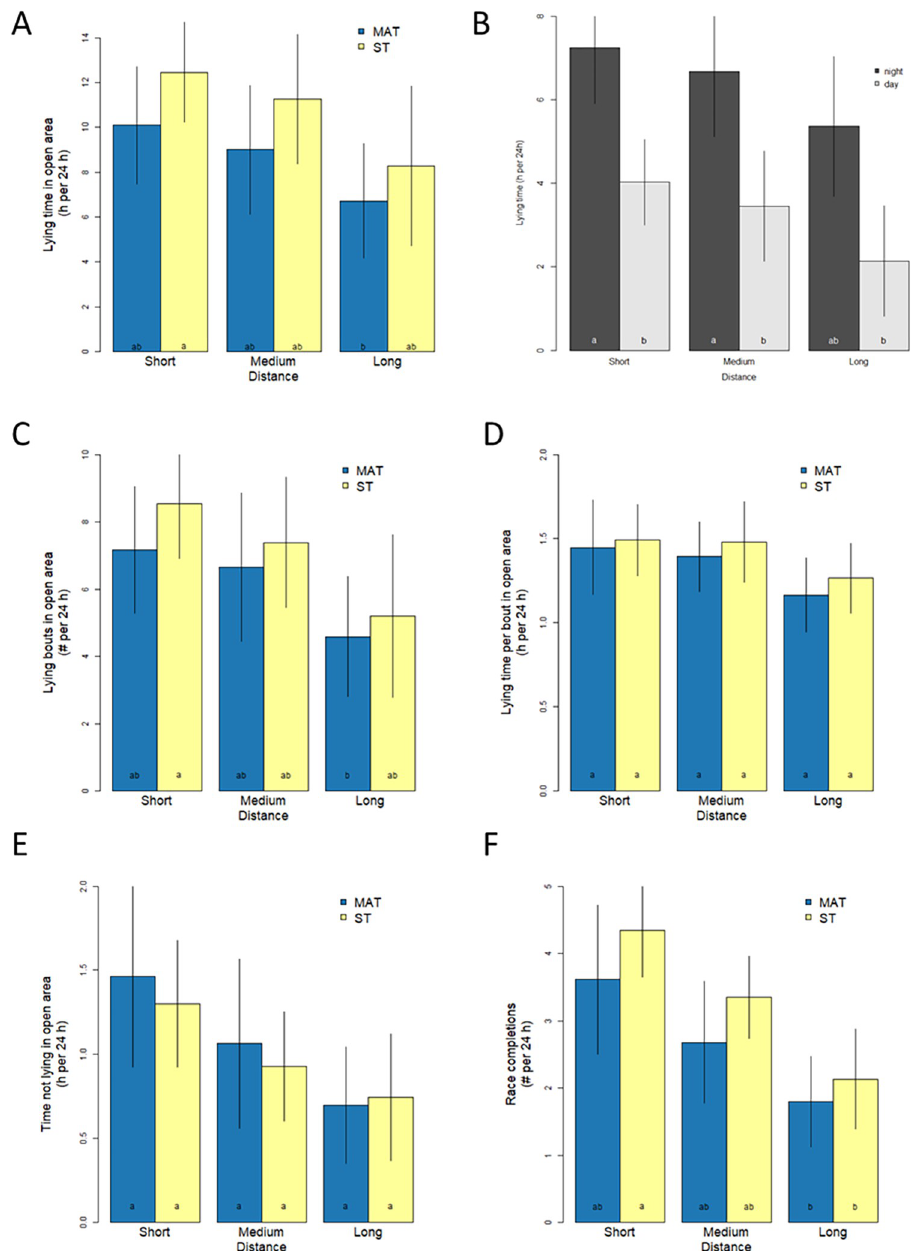
Fig 4. Lying, not lying and race completions as a function of distance choice treatment in open lying areas. Bar height represents the category mean and error bars represent the category 95% confidence interval (based on cow groups). Letters represent mean differences based on post hoc pairwise tests (Sidak corrected alpha = 0.05). Lying time is shown separately for when MAT or ST was available. A. Lying time per 24 h in open lying areas with MAT versus ST. B. Lying time per 24 h in open lying areas as night versus daytime. C. Frequency of lying bouts per 24 h with MAT versus ST. D. Average duration of lying bouts per 24 h in open lying areas with MAT versus ST. E. Time not lying per 24 h in open lying areas with MAT versus ST. F. Raceway completions per 24 h with MAT versus ST.